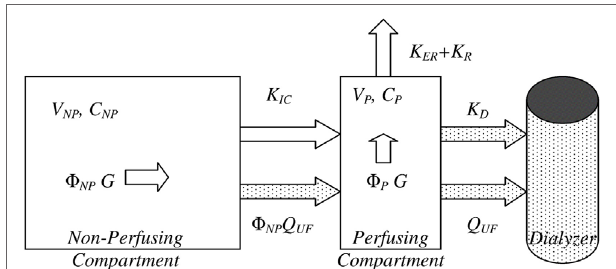
FigURe 2 | Bicompartmental beta-2 microglobulin ( β 2 M) kinetics. Bicompartmental system describing β 2 M kinetics consisting of a plasma/ perfusing (P) and non-perfusing/non-plasma (NP) with additional material fluxes for patients during hemodialysis sessions (stippled shapes). In each compartment, the symbols V, Φ , and C denote the absolute and fractional volume of each compartment and the concentration of β 2 M, respectively. Generation (G) takes place in both compartments, in direct proportion to their fractional volumes. K D , K ER , and K R are the dialyzer clearance, extrarenal, and residual renal clearances. Adapted from Supplementary Figure S1 of Ref. (117), reused under the Creative Commons CC BY license